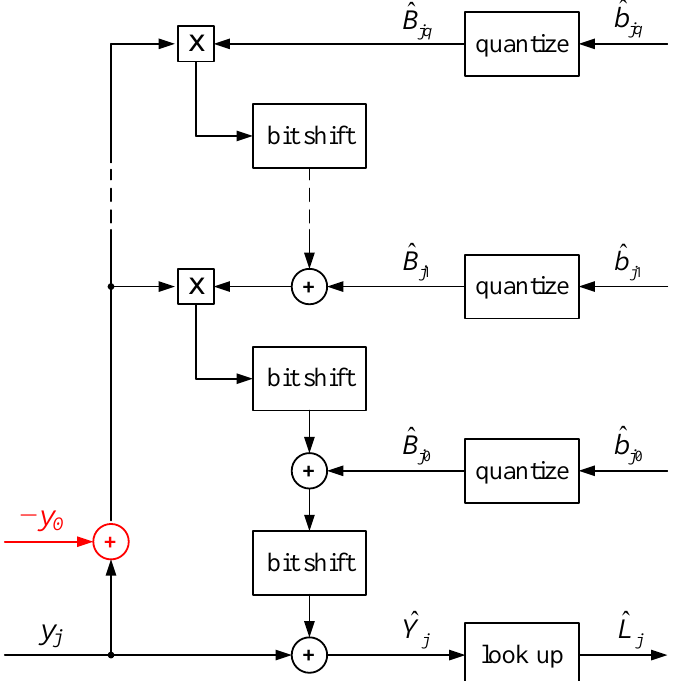
Figure 2. Fixed-point implementation of correction. Quantization and bit shifting introduce static and dynamic round-off errors, respectively, to the fixed pattern noise (FPN)